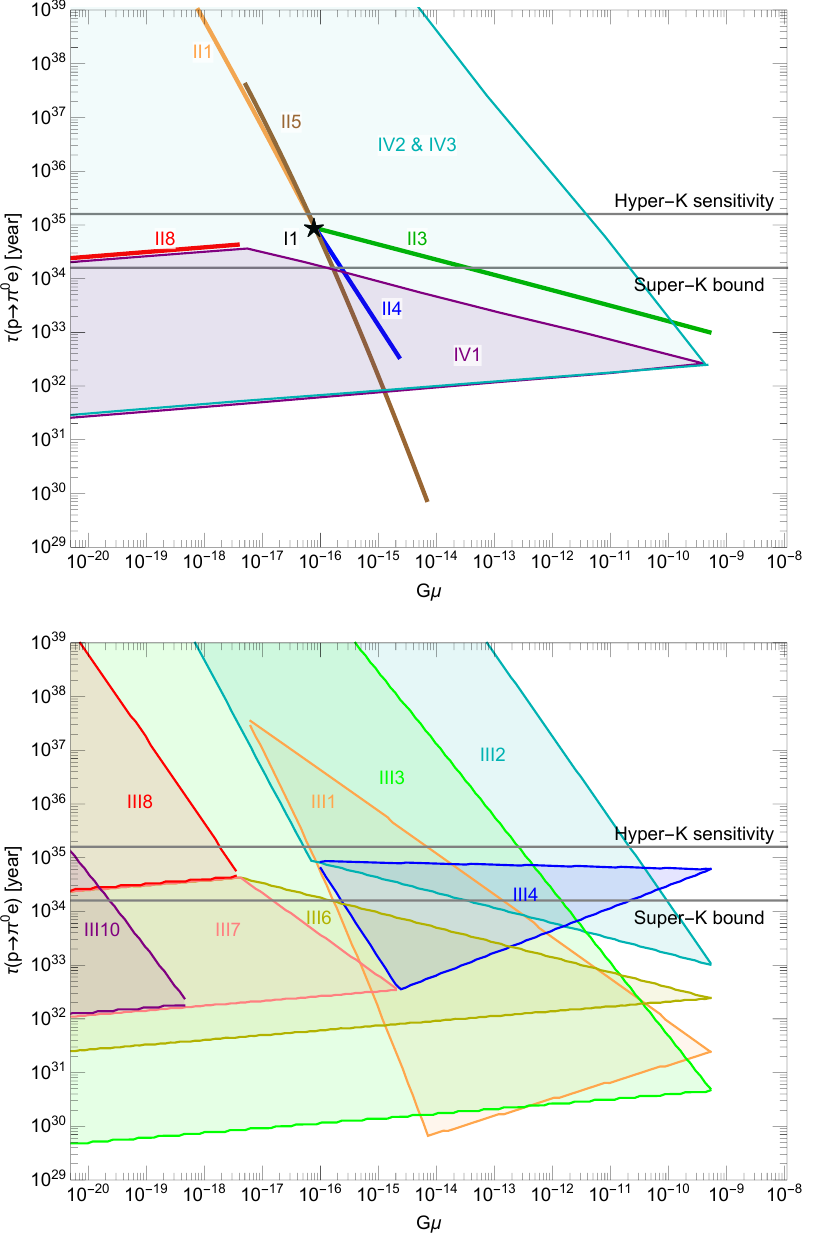
Figure 7 . Correlation between Gµ and the proton decay lifetime for chains which can generate observable cosmic strings. Chains with one, two and four intermediate scales are shown in the upper panel and those with three intermediate scales are shown in the lower panel. The colour for each chain is specified in both the upper and low panel. Labels for each chains are not shown in the upper panel as regions for these chains are highly